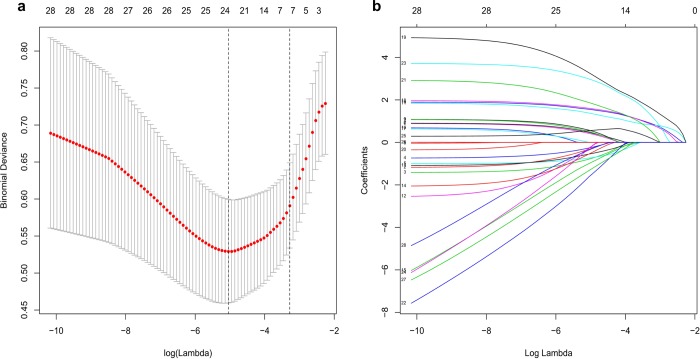
Selection of demographic and clinical features using the least absolute shrinkage and selection operator (LASSO) logistic regression model.(a). Selection of optimal parameters (lambda) from the LASSO model using five-fold cross-validation and minimum criteria. The partial likelihood deviance (binomial deviance) curve was plotted versus log(lambda). Dotted vertical lines were drawn at the optimal values using the minimum criteria and the 1 standard error of the minimum criteria (1-SE criteria). (b). LASSO coefficient profiles of 24 features. A coefficient profile plot was produced against the log(lambda) sequence. A vertical line was drawn at the value.